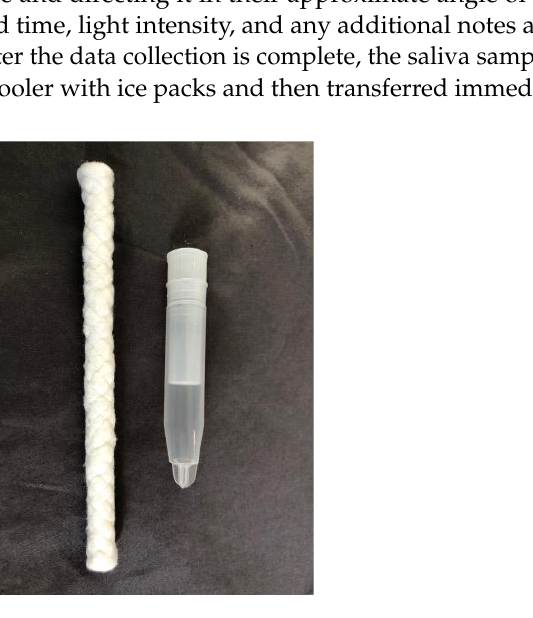
Figure 3. The braided dental cotton roll and tube used to collect saliva samples. Analysis